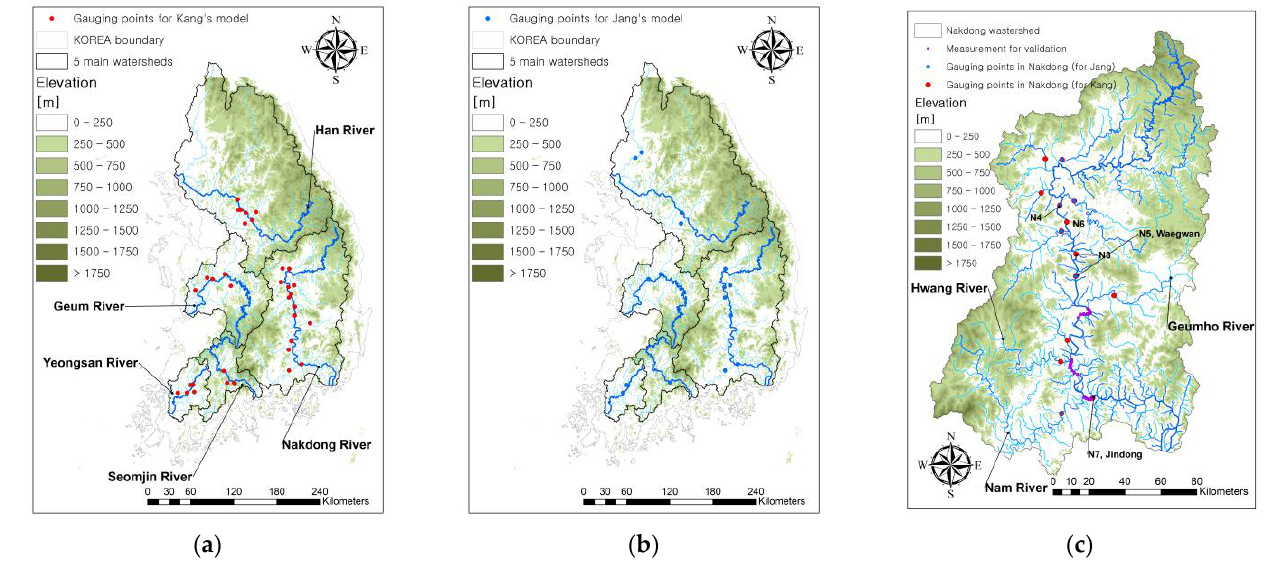
Figure 1. South Korea and ( a ) gauging points of calibration data for the model by Kang et al. [14], ( b ) gauging points of calibration data for Jang’s model [13], and ( c ) measurement points of validation data in the Nakdong River.